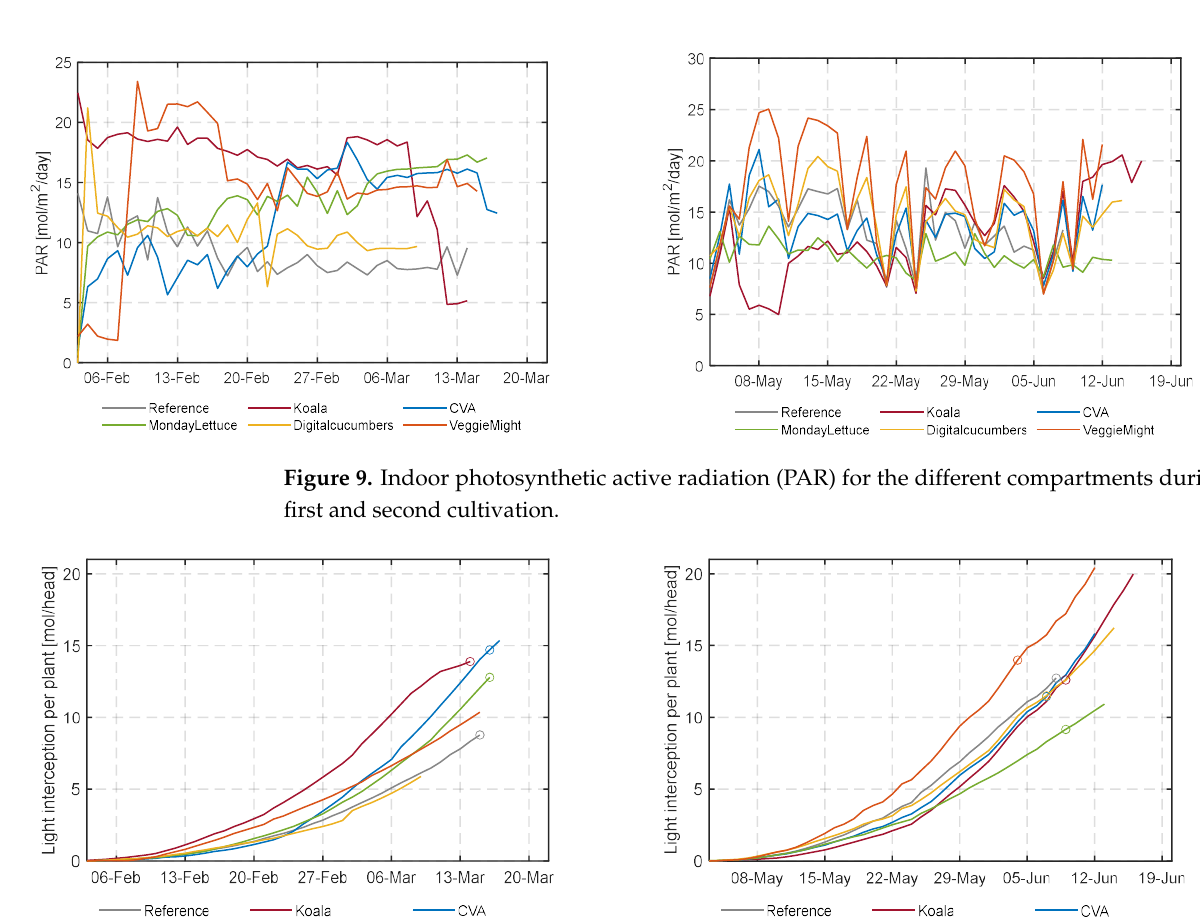
Table 1. The average density of lettuce heads for the two cultivations as calculated using Equation (1).